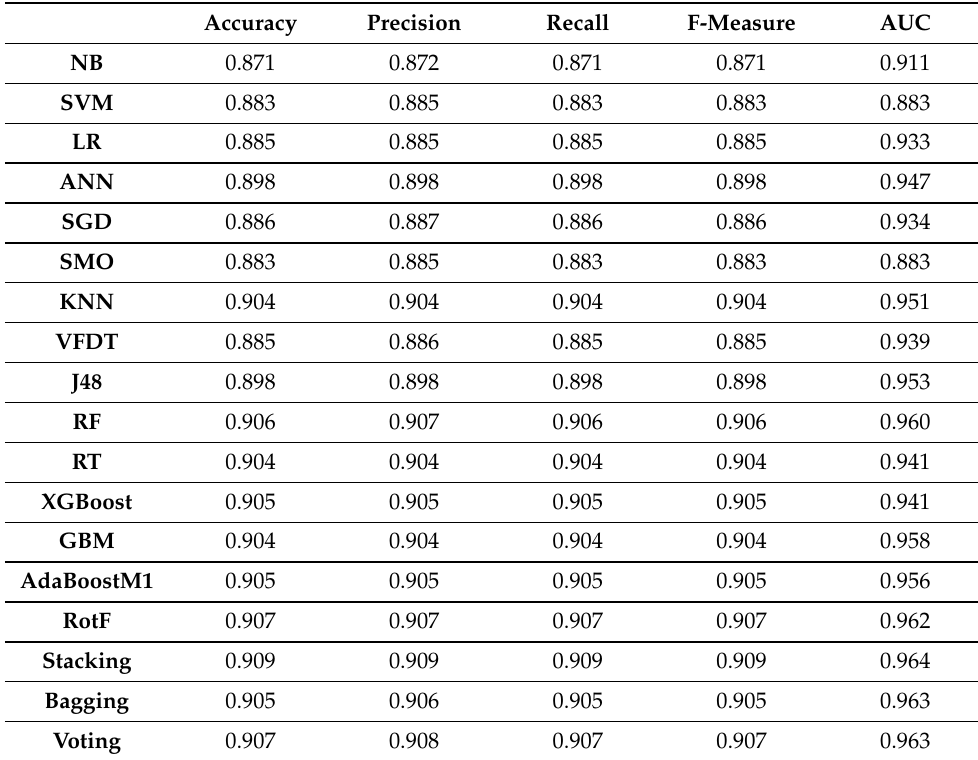
Table 5. Performance evaluation of ML models after SMOTE with 10-fold cross-validation.